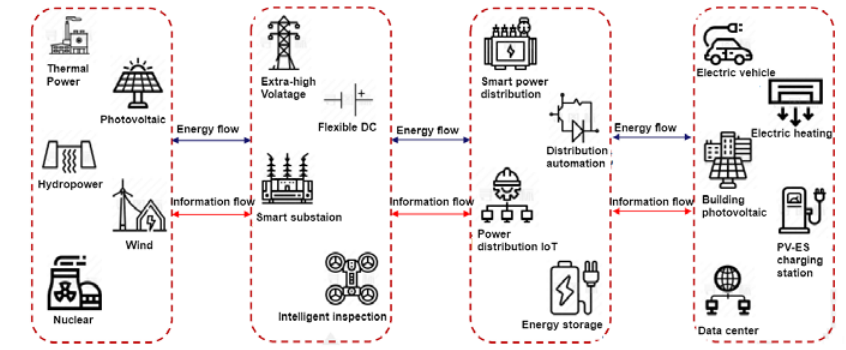
Fig. 1. Schematic diagram of new electric power system.